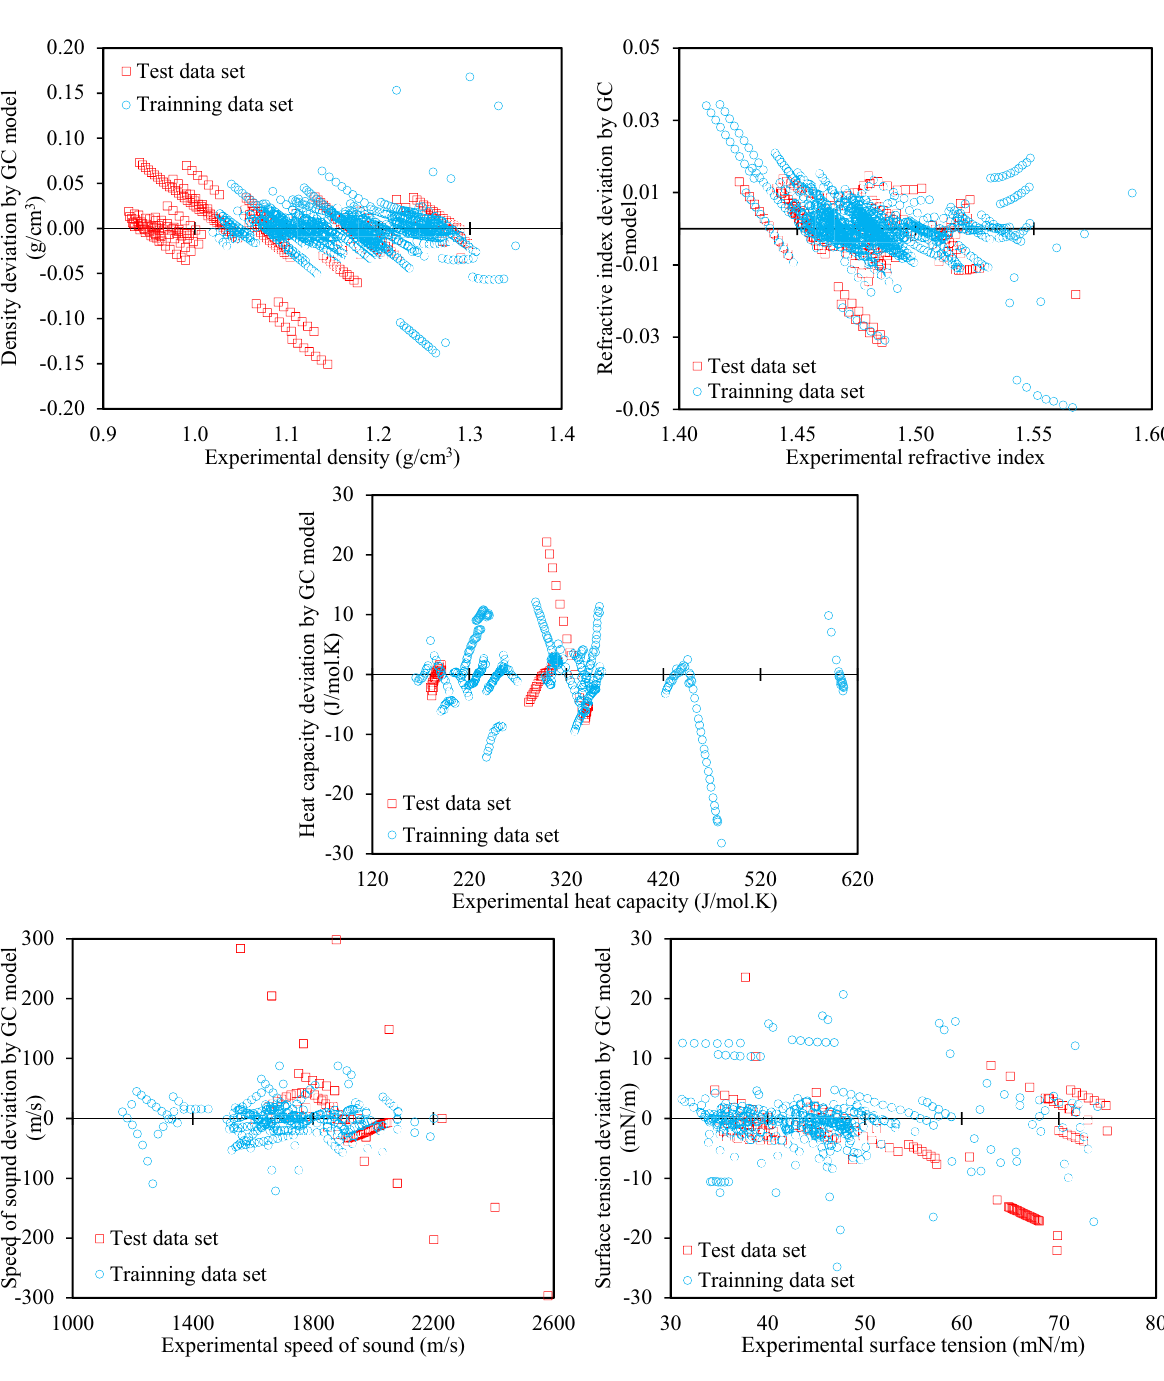
Figure 1. Deviations of the various physical properties from the experimental values for the training and test data sets by the proposed GC